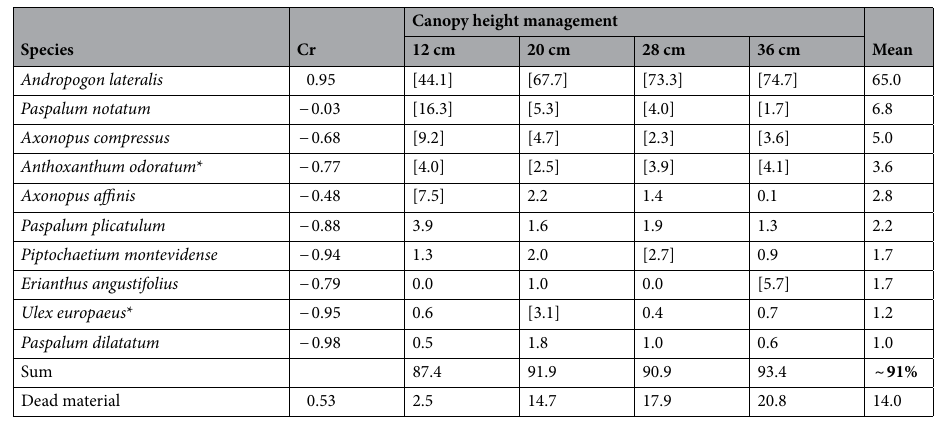
Table 2. Rank consistency index (Cr) 51 and proportion of species (%) in the mean forage mass of the final two assessments (autumn and spring 2017) undertaken in a Highland grassland dominated by Andropogon lateralis Nees and managed under different canopy heights and intermittent stocking grazing. The percentage of the most important species was calculated excluding the dead material component; however, as there was considerable participation of this in the forage mass, the percentage and Cr of this component based on the total forage mass were also calculated. *Exotic species. The five most important species at each management height are given in